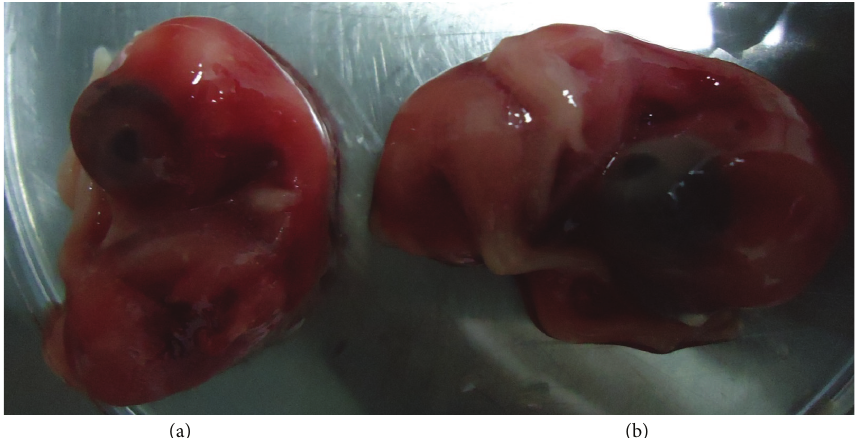
Figure 1: Inoculation of viral suspension in 9-day old embryonated chicken egg showing evidence of severe haemorrhage in infected embryo (a) as compared with negative control (b) after 24 hours